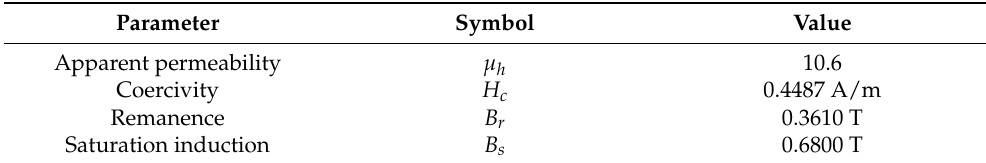
Table 1. Parameters of the hysteresis strips.